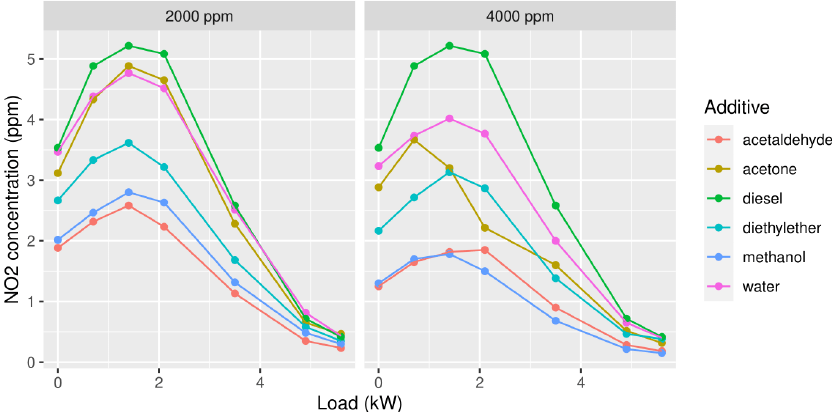
Figure 3. Concentrations of NO 2 in the exhaust gas in function of the load, with 2000 ppm ( left column ) or 4000 ppm ( right column ) of each of the oxygenates added to the diesel.